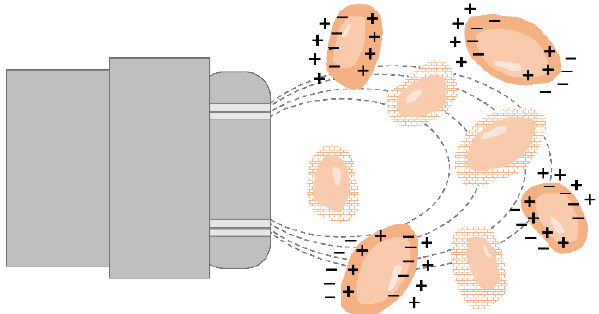
Figure 5. Principle of capacitance measurement for cell viability determination. Only viable cells are polarized by the electric field and contribute to the capacitance signal. Dead cells cannot be polar-